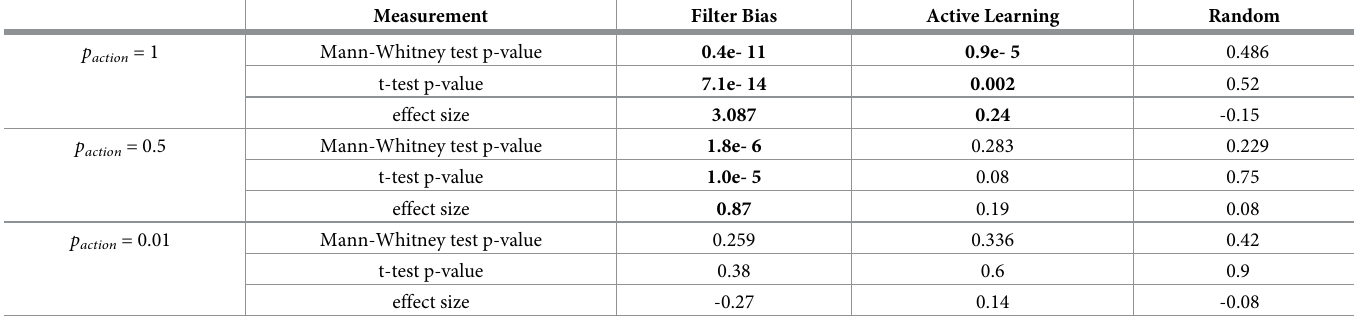
Table 5. Results of the Mann-Whitney U test and t-test for the boundary shift of the computed three forms of iterated algorithmic bias based on the different proba- bility levels of human action. Here, effect size is ES = ( Boundary | t = 0 − Boundary | t = 200 )/ standard . dev . Bold means the significance at p < 0.05. The more the human reacts to the system, the larger is the boundary